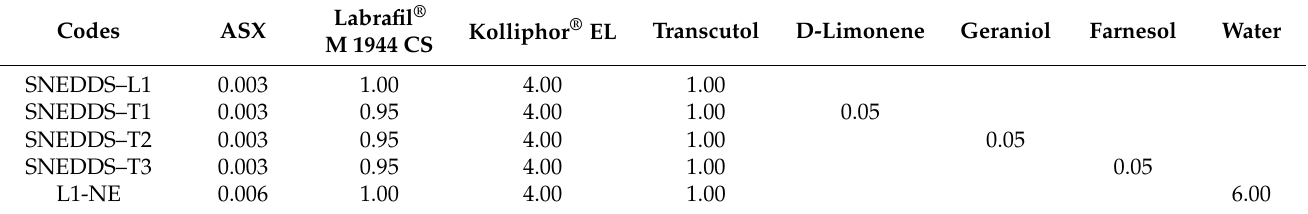
Table 1. ASX-SNEDDS formulation compositions (all excipients as w / w